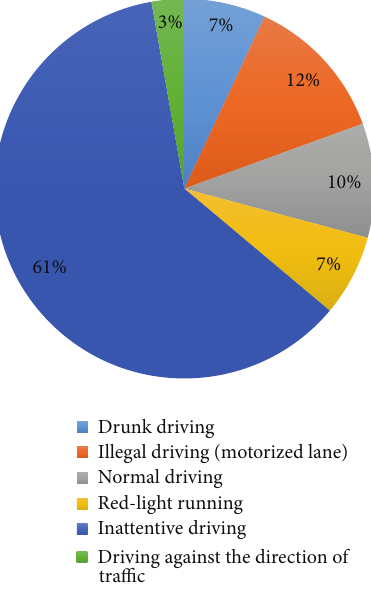
Figure 2: Precrash behaviors of e-bike riders.